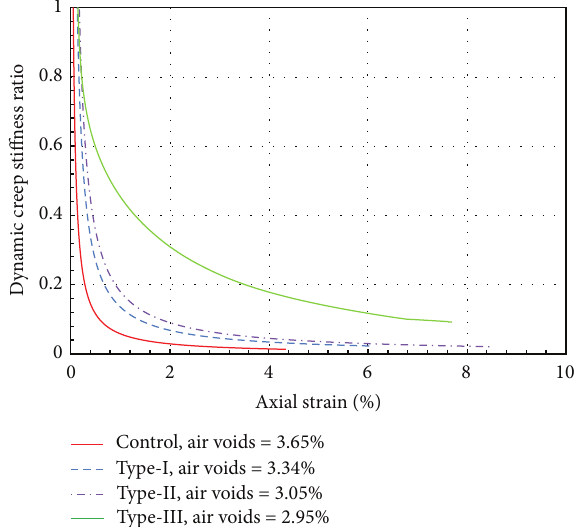
Figure 10: Variation in dynamic creep stiffness with respect to